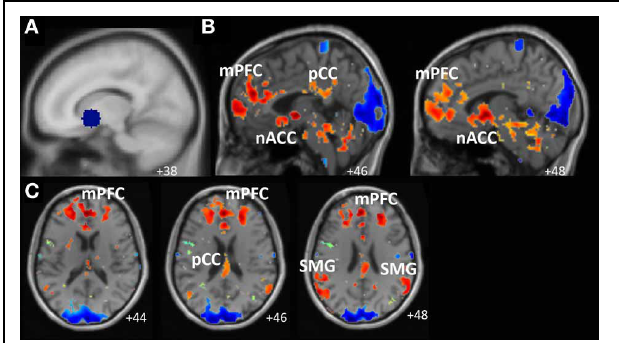
FIGURE 2 | Results of resting-state scan analysis revealed that the signal in the patient’s nucleus accumbens (nACC) fluctuated with four default network regions: the medial prefrontal cortex (mPFC), the posterior cingulate cortex (pCC), and bilateral supramarginal gyri (SMG). Panel (A) depicts the seed regions used to generate the resting-state maps. Panel (B) depicts results from a sagittal orientation. Panel (C) depicts results from an axial orientation. Results displayed on participant’s T1 anatomical image.